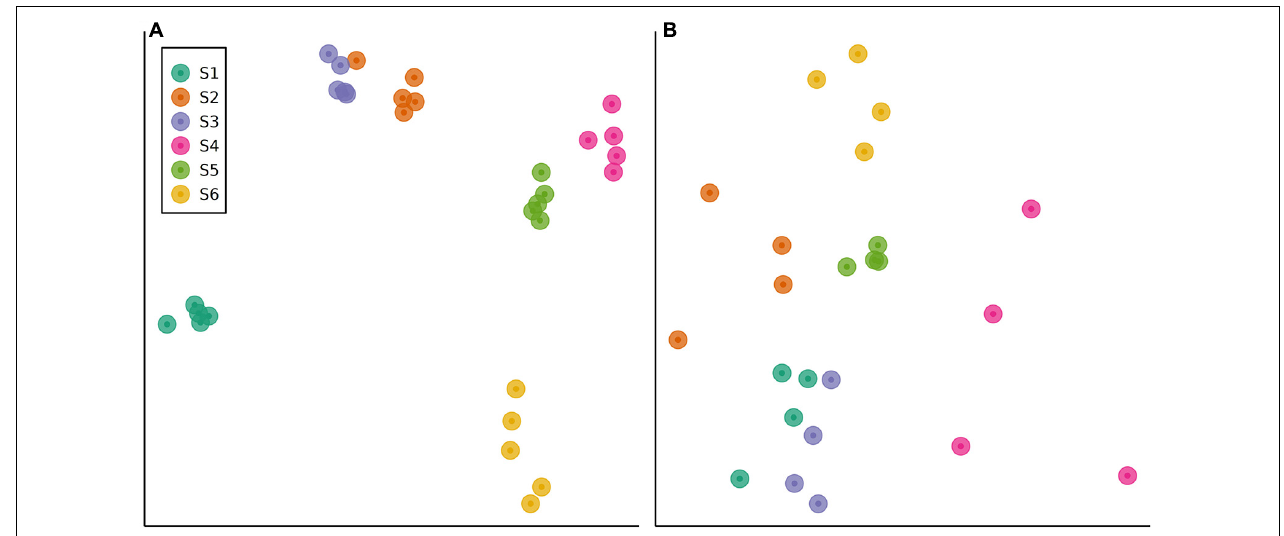
FIGURE 3 | Non-metric multidimensional scaling (nMDS) ordinations of sediment communities in field sites sampled along a eutrophication gradient in the Archipelago Sea (Baltic Sea, Finland). The ordinations were derived from Aitchison resemblance matrices calculated from Illumina MiSeq OTU abundance data. Data are shown for (A) bacterial communities (stress = 0.04) and (B) eukaryotic communities (stress = 0.16).